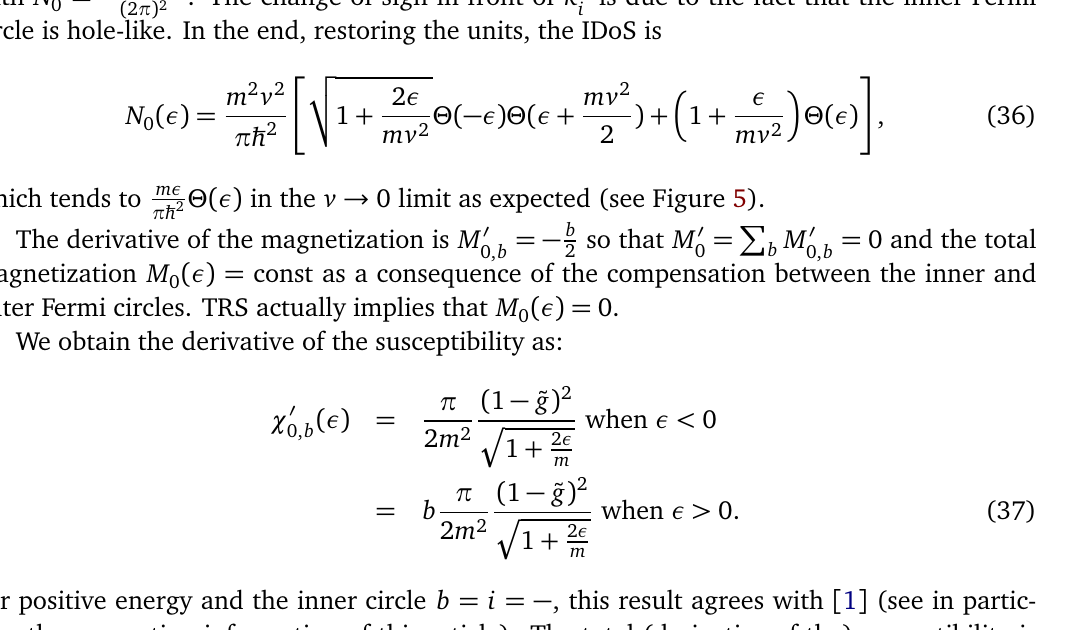
] , derivative π [ blue 0